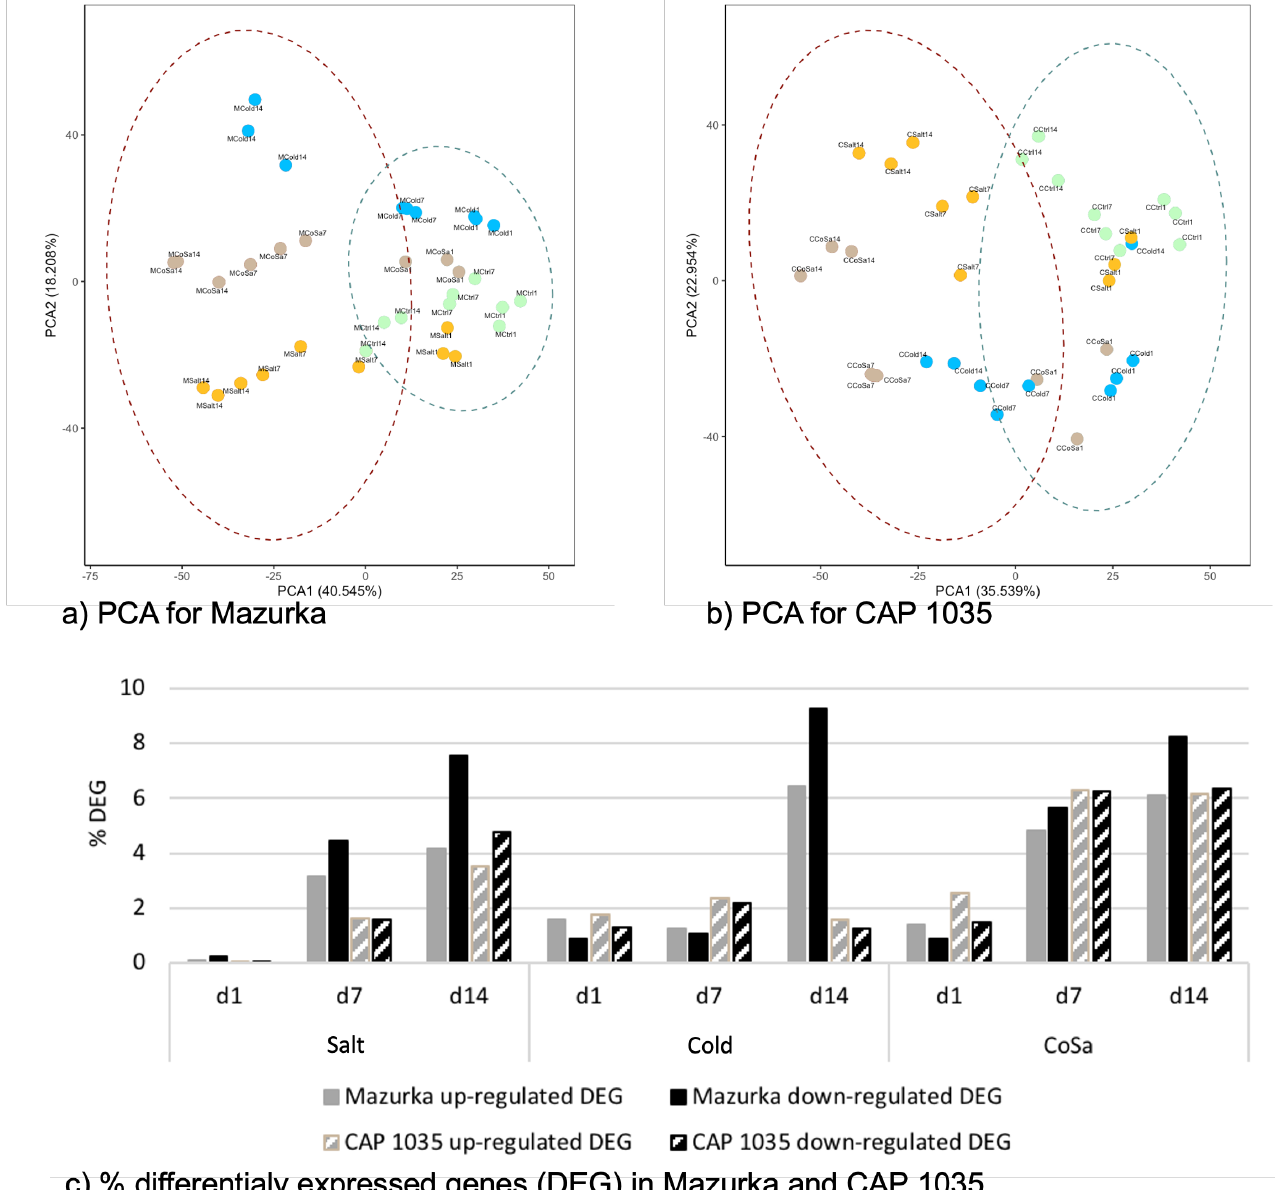
Figure 2. RNASeq analysis reveals overall similar behavior in the two pepper species. Principal component analysis for Mazurka ( a ) and CAP1035 ( b ) indicating responsiveness to the harvest time points and stress treatments, shown by comparison of principal component 1 (PC1) versus principal component 2 (PC2). Control = green, Cold = blue, Salt = red, CoSa = light brown ( c ) Percentage of differentially expressed genes (DEG) in Mazurka (plain columns) and CAP1035 (striped columns). Differentially expressed genes were obtained by global comparison of expression data for the respective stress treatment with the control sample. Percentage of down-regulated genes is shown in grey bars, and up-regulated genes in black bars, respectively. FDR <